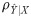
Case I: periodic–constant coupling coefficients.(a) ρY^∣X at L = 500 over the range of μ and η given by Eq (10) and for random initial condition. (b) Difference between the CCM coefficients, ρY^∣X−ρX^∣Y, at L = 500 over the specified range of μ and η.